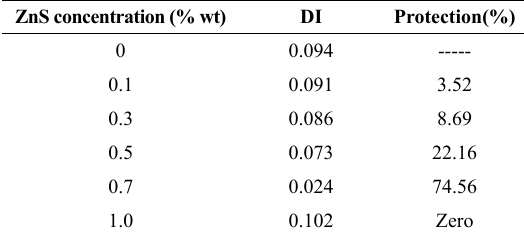
Table 2. Viscosity results for PVC and PVC/ZnS at different concentrations.